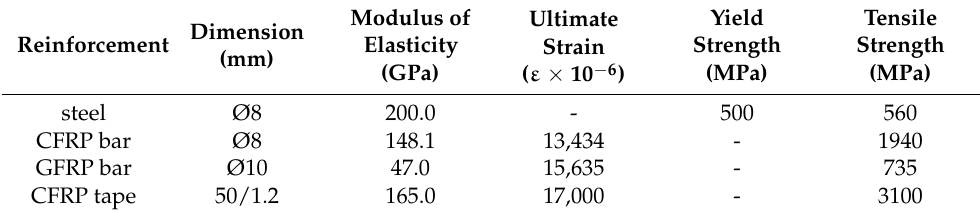
Figure 5. Determination of the characteristics of FRP materials: ( a ) Test specimens; ( b ) Test setup; ( c ) Specimens after testing [29]. Table 5. Mechanical properties of steel and FRP reinforcement.